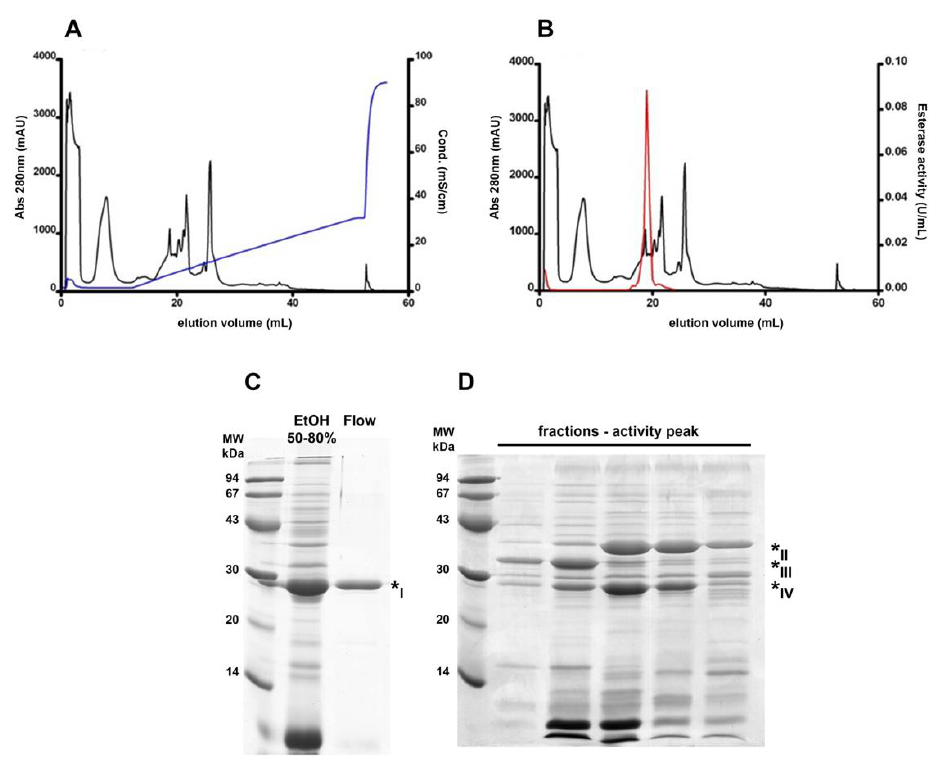
Figure 2. Different esterase B behavior in an anion exchange chromatography. Online absorbance (280 nm) detection was performed (black curves in ( A , B )) and each sample was further assayed for esterase activity (red curve in ( B )). Resin-bound protein elution was performed by a linear gradient of elution buffer (blue curve in ( A )). SDS PAGE analysis shows a single observable band in the flow-through fraction ( C ) and enrichment in three bands around the 30 kDa marker in the activity peak fractions ( D ). Band numbering corresponds to the MS protein identification data from Table 2.